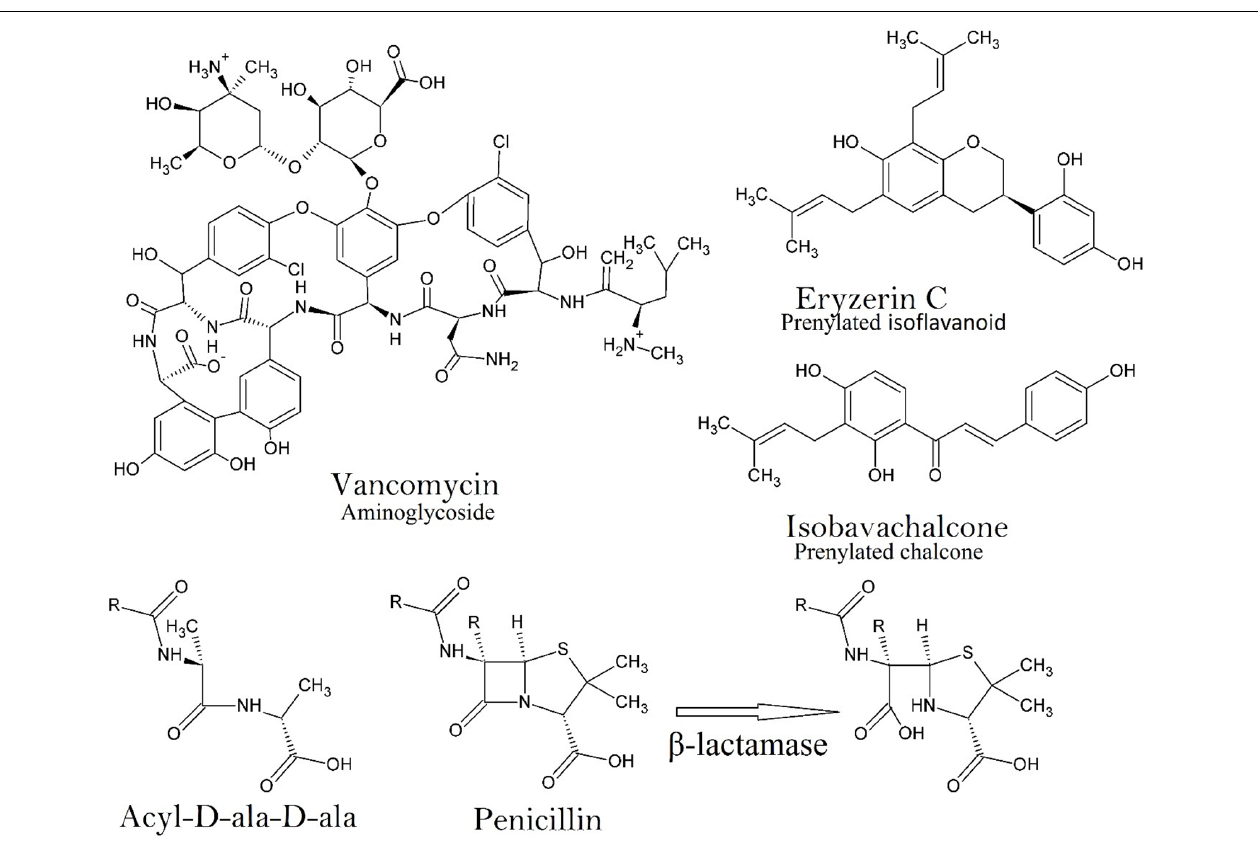
FIGURE 1 | An example of the chemical structure of an aminoglycoside (Vancomycin) showing the complexity of just one of some of the frontline antibiotics. Two structures are depicted that are representative of category 1 antimicrobials (Eryzerin C – prenylated flavonoid; Isobavachalcone – prenylated chalcone), which are among the most potent plant derived nitrogen deficient antimicrobial compounds in nature. The prenyl group enhances lipophilicity and bacterial membrane penetration, the adjacent phenolic OH group (on the same ring as the prenyl group) is essential for efficacy. The structural similarity of acyl-D-ala-D-ala to penicillin is important for the specificity of penicillin since human proteins have no D-amino acids. The activity of β -lactamase against penicillin is on the β -lactam moiety, which hydrolyzes the amide bond (Patrick,